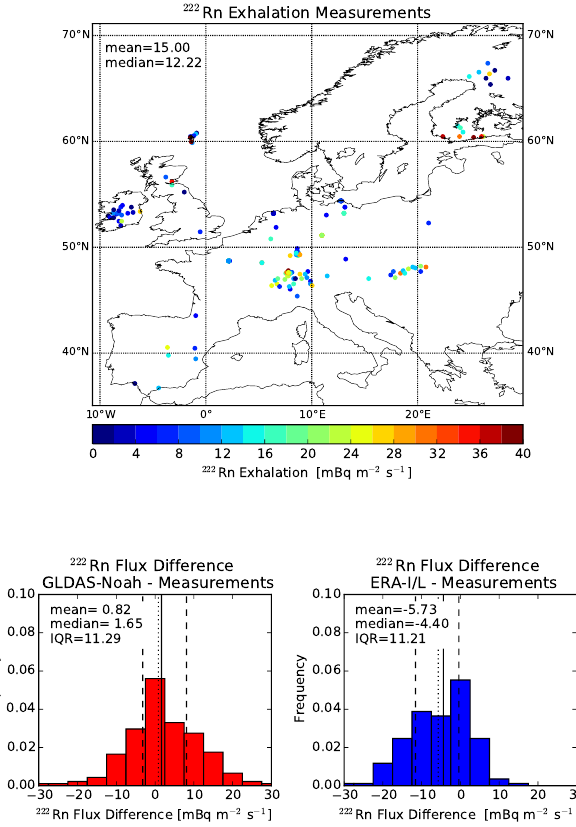
Figure 8. Map of episodic 222 Rn flux observations in Europe (upper panel) and frequency distribution of model–data differences at sites where co-located data exist (GLDAS-Noah-based fluxes: red his- togram, ERA-I/L-based fluxes: blue histogram). All measurement data are provided in the Supplement (Table